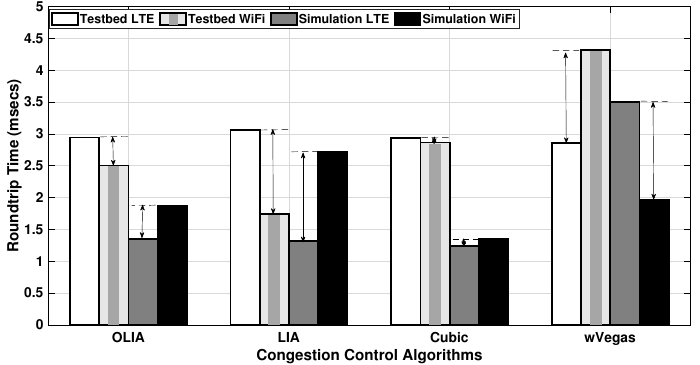
Figure 12. Setup 1 uplink MPTCP RTT for 75 MB